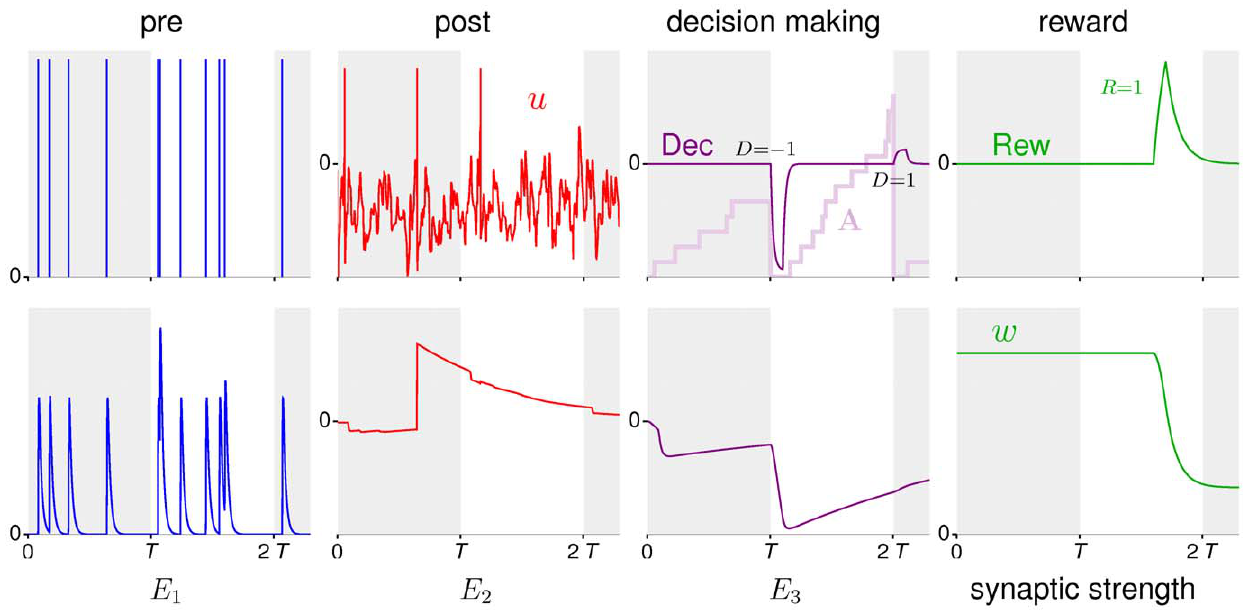
Figure 2. Examples for the modulatory signals and the resulting traces in the plasticity cascade of a synapse. Top row: An input stream (stimulus boundaries marked by shading) gives rise to the pre- and the postsynaptic activity shown in the first two panels. The next panel shows the population activity arising from the stimuli as well as the forced choice decisions made at times T and 2 T . Of the total 15 population neurons used in this example simulation, 5 fired during the the first stimulus (i.e. upto time T ), for the second stimulus 12 fired. Further, during presentation of the second stimulus external reinforcement generates a reward signal (rightmost panel). Bottom row: Each of the stages in the plasticity cascade depends on the trace in the previous stage and the modulatory signals in the top row as indicated by the diagram in Fig. 1B. Mathematically, E 1 is determined by Eq. (1), E 2 by (2), E 3 by (3) and w by (4).